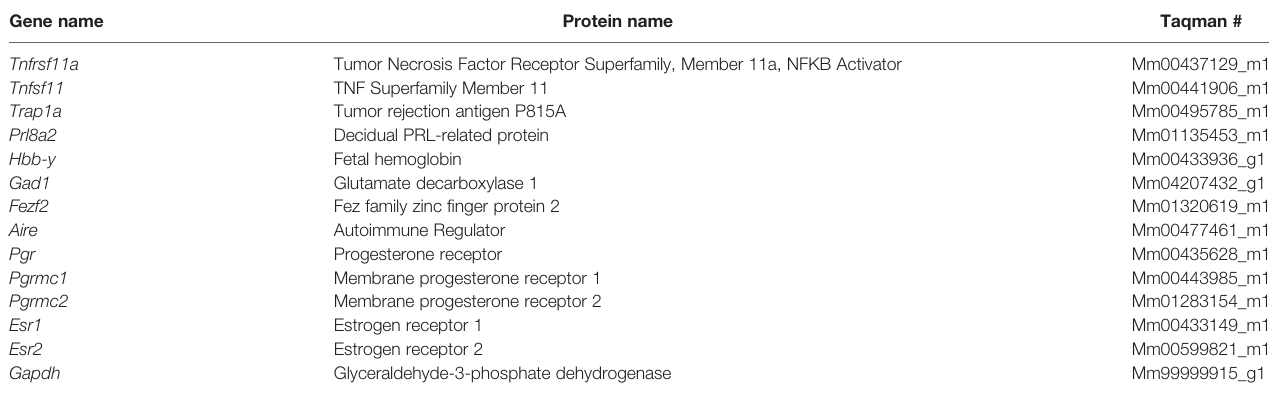
TABLE 1 | List of Taqman probes used for